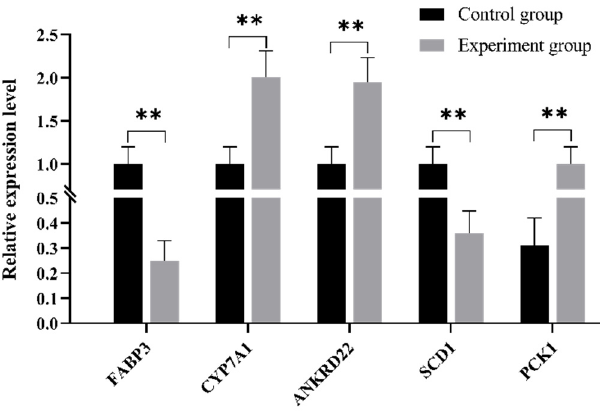
Figure 3. The quantitative real-time PCR validation of randomly selected differentially expressed genes ( FABP3 , CYP7A1 , ANKRD22 , SCD1 , and PCK1 ). The x-axis represents differentially expressed genes, and the y-axis represents the relative expression levels of the genes. ** on the top of lines or bars indicates a significant difference ( p < 0.01) between the high-addition group and control group.